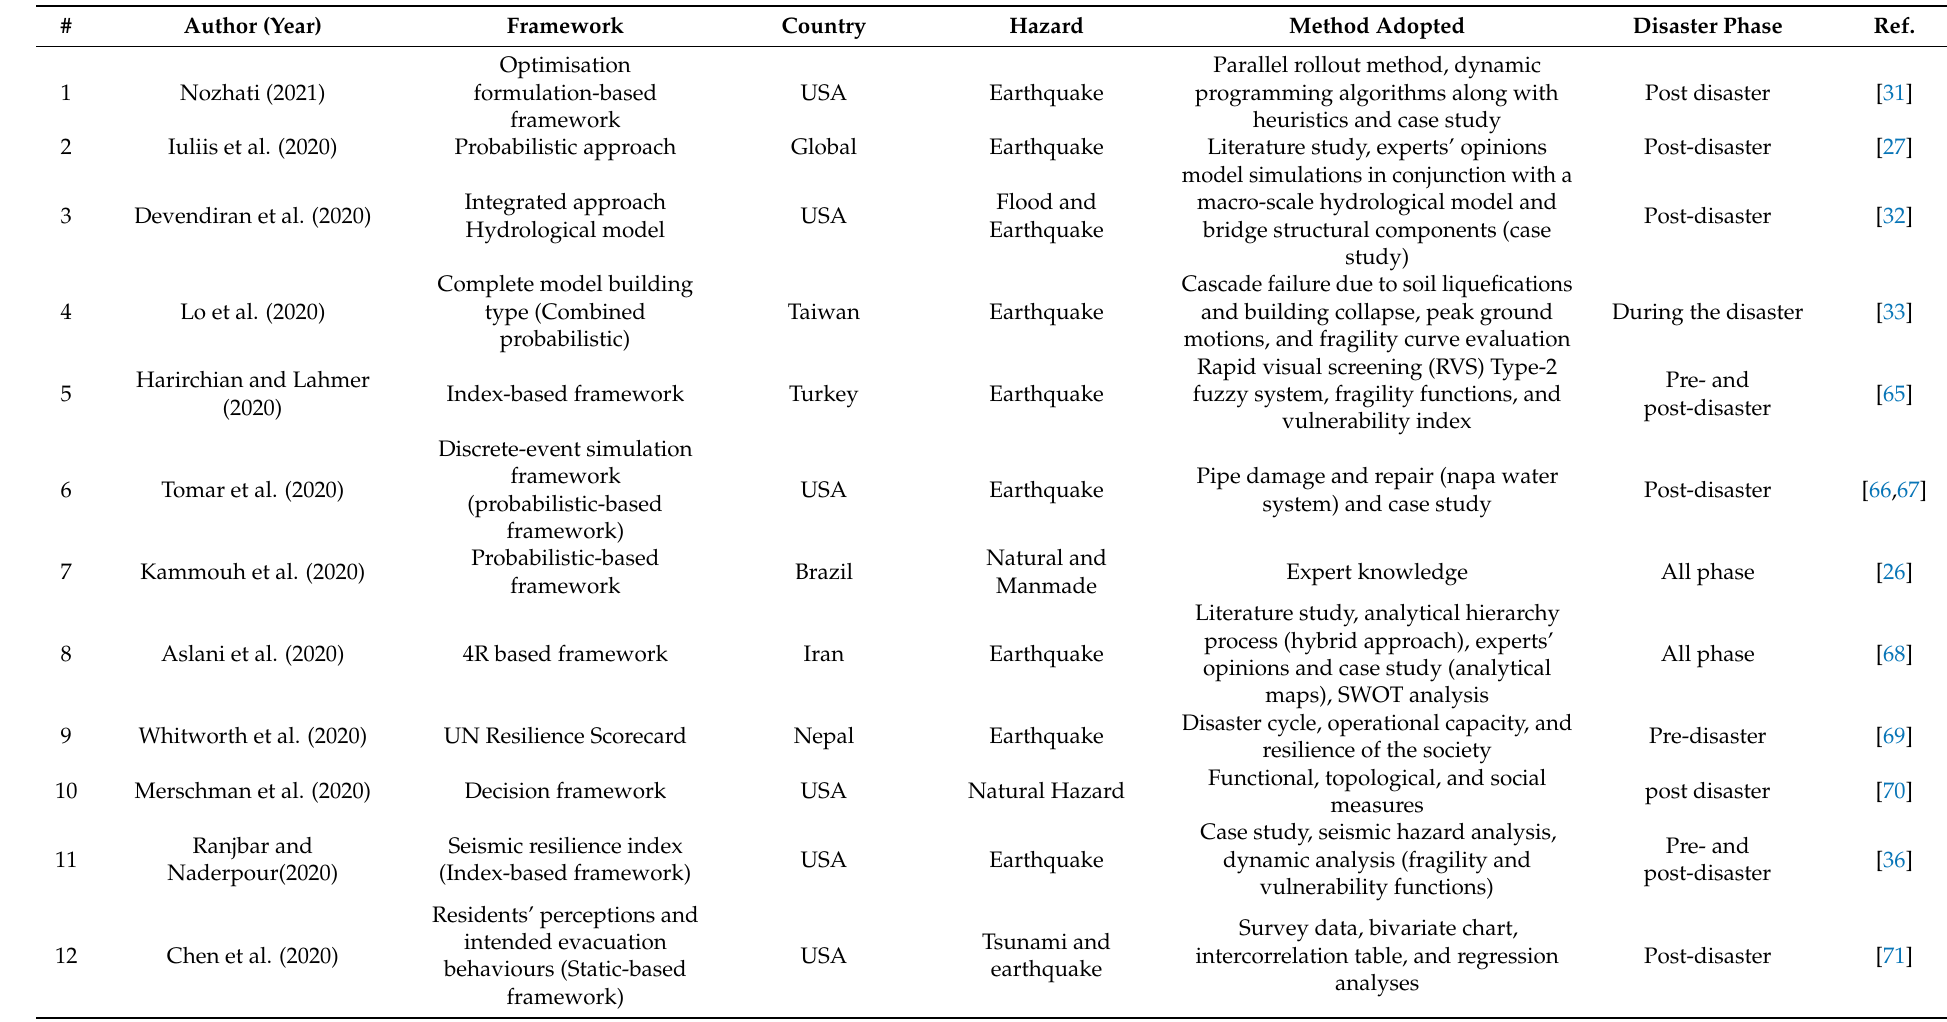
Table 1. Infrastructure Resilience Frameworks Assessed in this